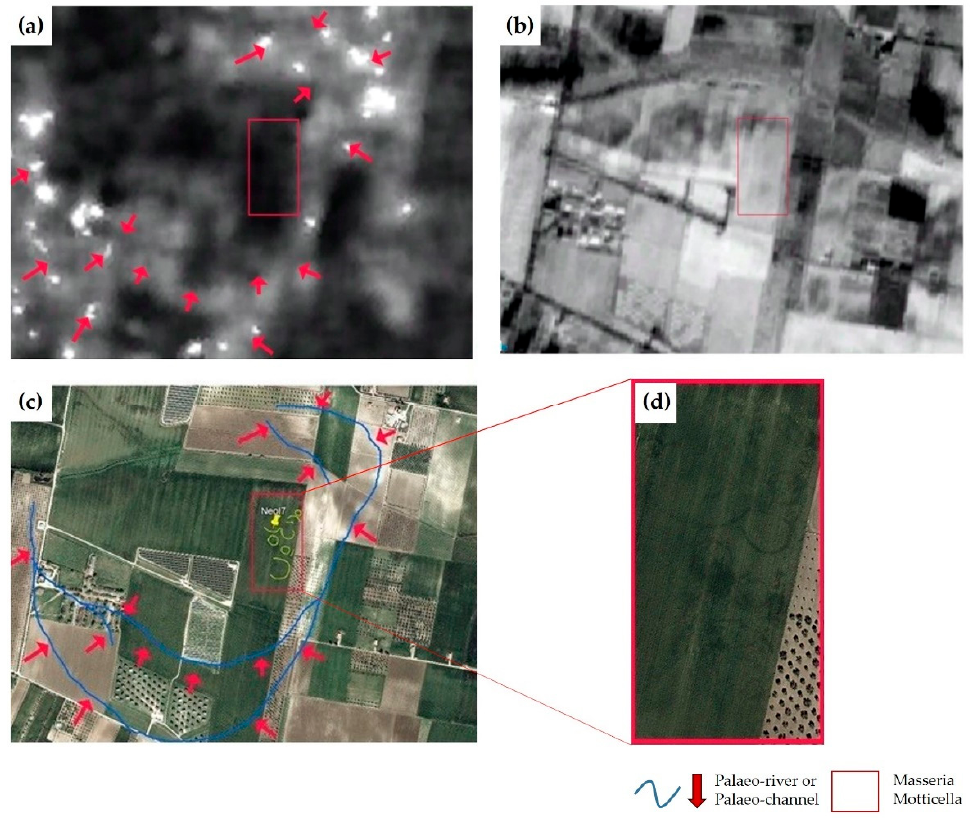
Figure 10. Masseria Motticella (Neolithic settlement), palaeo-landscape (see Figure 8, II for its location) including palaeo-rivers and palaeo-channels observed from: ( a ) VV Sentinel 1 data acquired on 19 October 2019; ( b ) Sentinel 2 based soil map acquired on 20 October 2019; ( c ) Google Earth image acquired on 10 October 2014; ( d ) shows a detail of 10c, including some circular features related to the Neolithic compound.